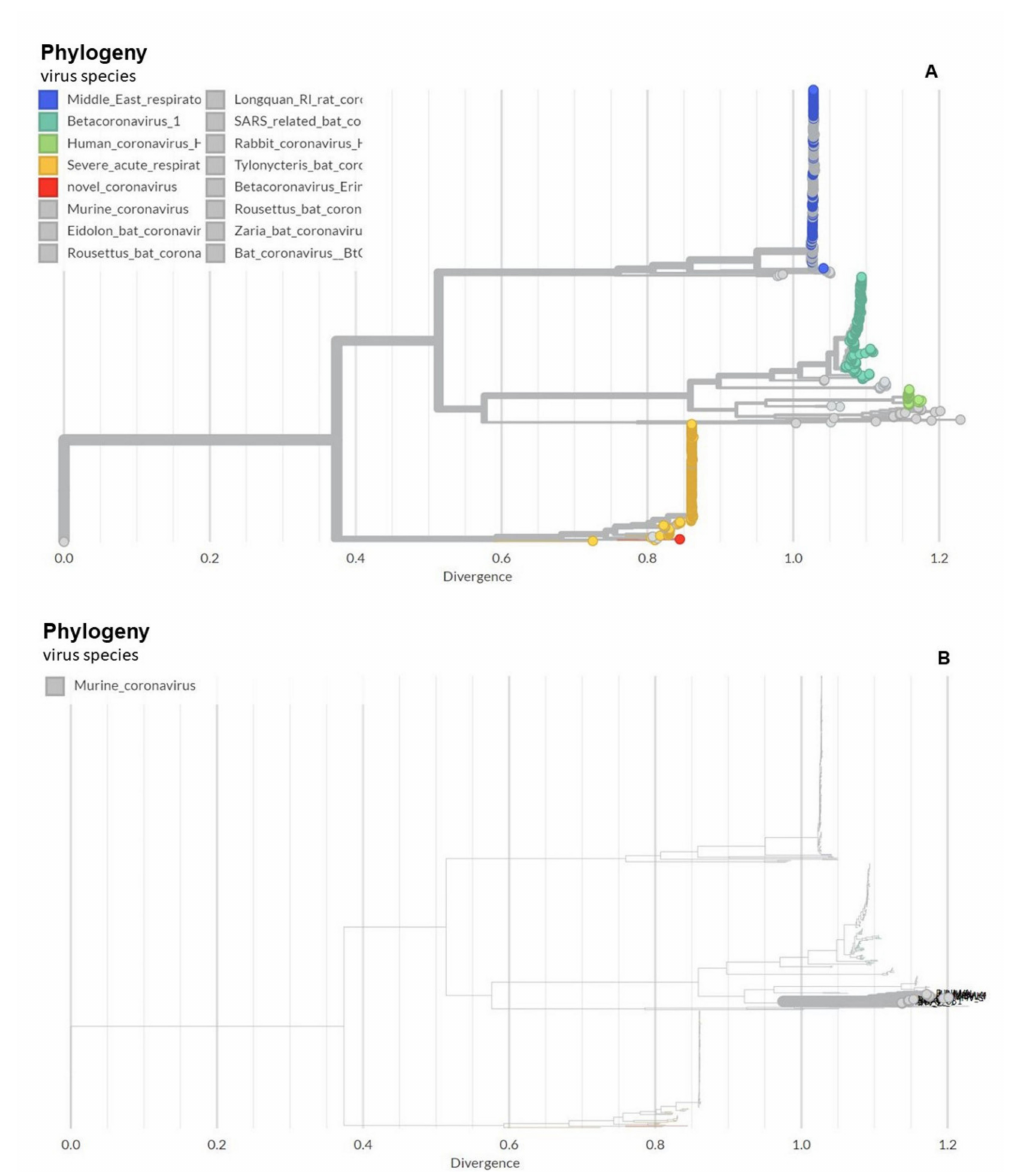
Figure 1. Phylogeny of coronaviruses including the novel coronavirus SARS-CoV-2. ( A ) Phylogeny of coronaviruses including the novel coronavirus SARS-CoV-2.; ( B ) Phylogeny of murine coronaviruses including the murine hepatitis